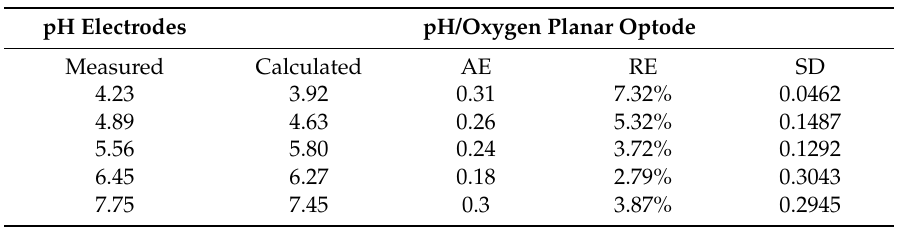
Table 2. Comparison of the pH/Oxygen planar optode and electrodes for pH measurements. AE: absolute error; RE: relative error; SD: standard deviation.